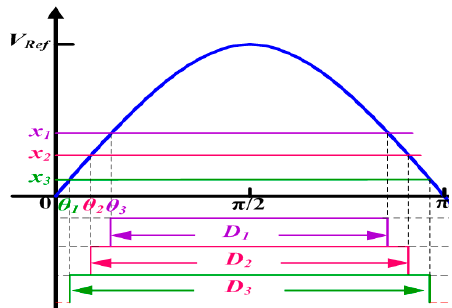
Figure 5. Variation of duty cycle with respect to DC offset value x 1 , x 2 and x 3 .